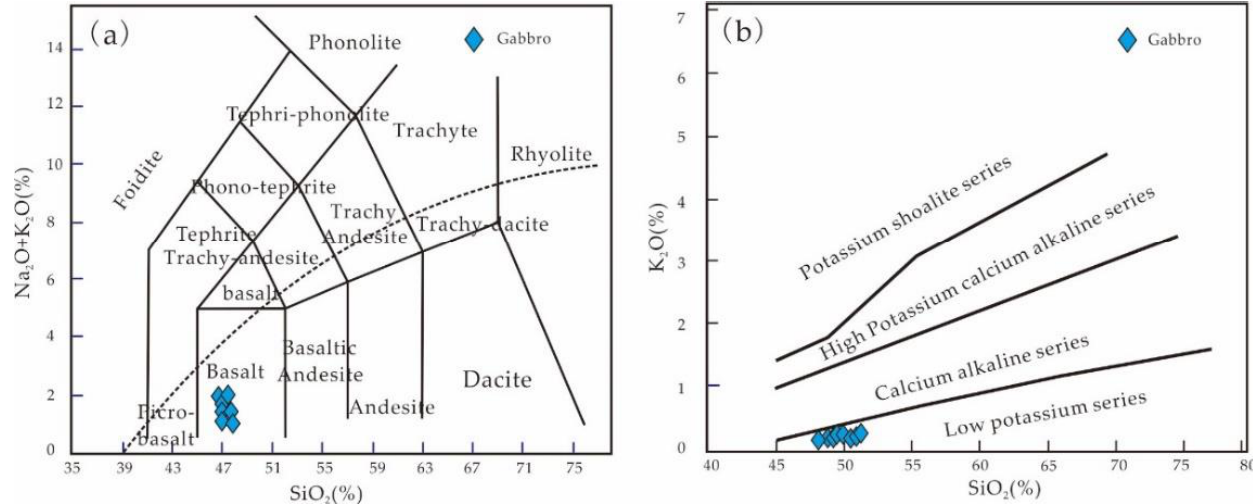
Figure 5. TAS discrimination diagram and rock series of gabbro, Laguoco, Tibet: ( a ) TAS discrimi- nation diagram of samples modified after [30]; ( b ) discrimination diagram of rock series modified after [31].